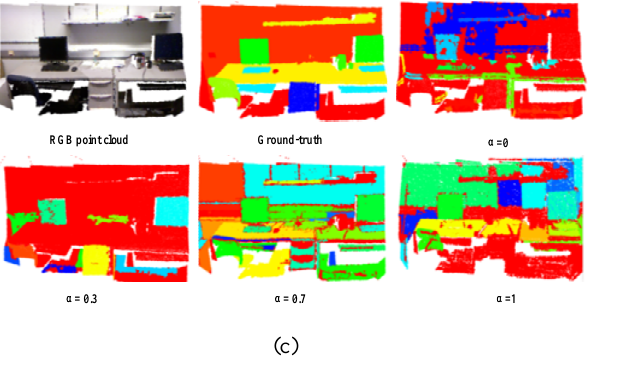
Figure 5. Comparison of the segmentation results along with RGB point cloud and ground-truth regarding to different weight values. (a) Scene 1. (b) Scene 2. (c) Scene 3.